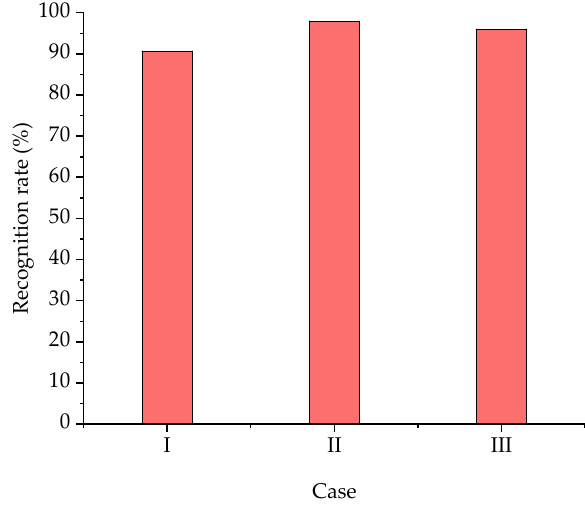
Figure 8. Resulting plot of the experiment.